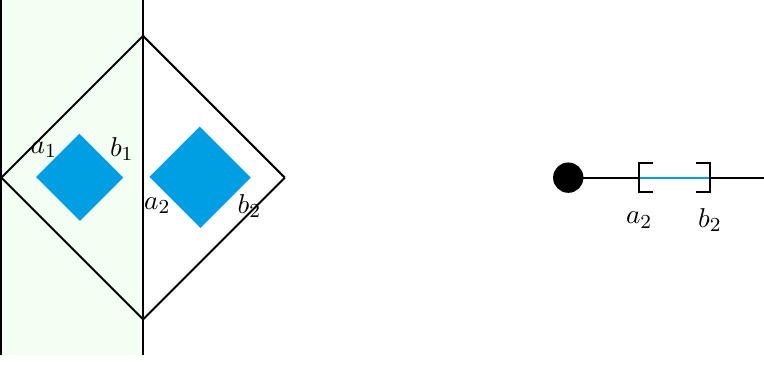
Figure 2 . The entanglement wedge of region [ a 2 ; b 2 ] in the quantum mechanical description contains the region [ a 2 ; b 2 ] itself plus an island [ a 1 ; b 1 ] (the blue regions in the left